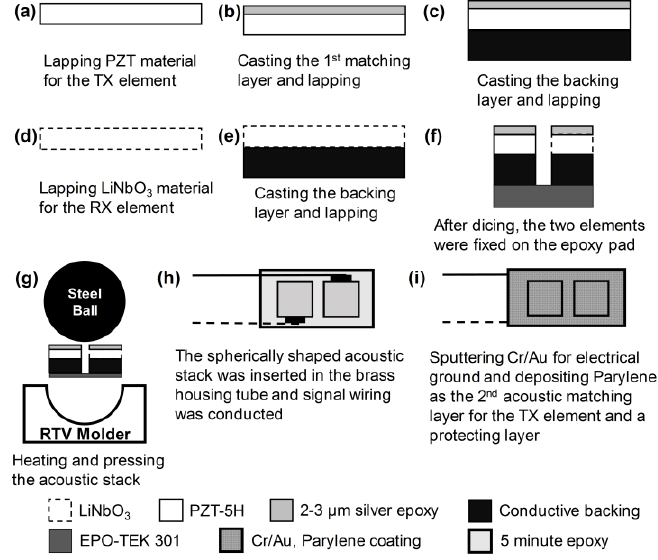
Figure 5. Illustration of the fabrication process for the dual-element focused transducer.